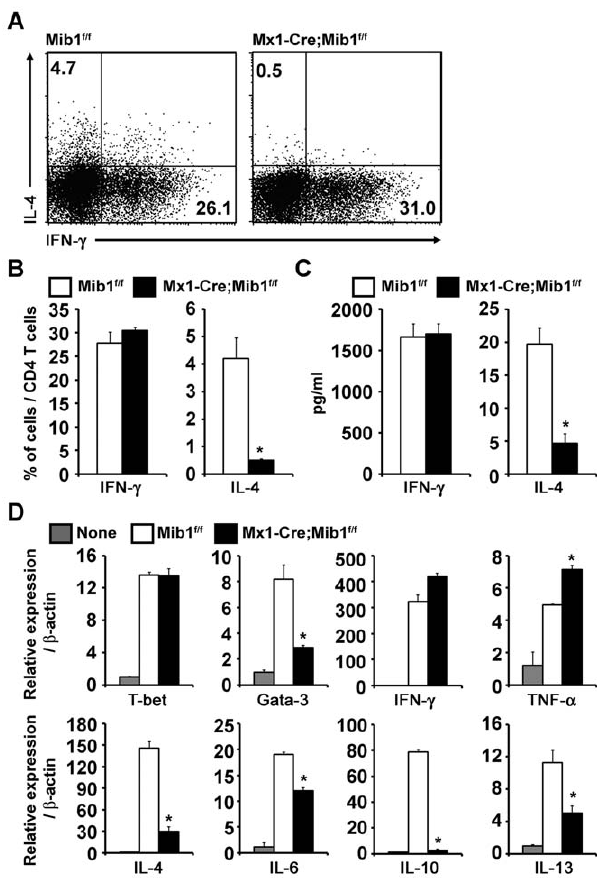
Figure 5. Absence of Mib1 in DCs specifically impairs Th2 differentiation. A , Purified naive OT-II CD4 + T cells were cultured with peptide pretreated Mib1 f/f or Mx1-Cre;Mib1 f/f DCs. After 5 days, viable cells were re-stimulated with PMA and ionomycin for 6 h, and the intracellular levels of IFN- c and IL-4 were analyzed by flow cytometry. The numbers indicate the percentage of cells within the gates. A representative of three independent experiments is shown. B , The average percentage of activated CD4 + T cells producing IFN- c and IL-4 (as in [ A ]) from three independent experiments. C , Viable activated CD4 + T cells were harvested, and an equal number of cells in each group were re-stimulated with 1 m g/ml plate-bound anti-CD3. The supernatants were removed after 48 h, and cytokine concentrations were determined by ELISA. D , Quantitative real-time RT-PCR analysis of T-bet, Gata-3, Th1 related cytokines (IFN- c and TNF- a ), and Th2 related cytokines (IL-4, IL-6, IL-10, and IL-13) in purified CD4 + T cells unstimulated ( None ) or stimulated by Mib1 f/f or Mx1-Cre;Mib1 f/f DCs. Data represent mean 6 SD; *, P , 0.05. doi:10.1371/journal.pone.0036359.g005 ELISA analysis (Fig. 5 C ). In addition, expressions of Gata-3, a central factor for the differentiation of Th2 cells, and various Th2 cytokines such as IL-4, IL-6, IL-10, and IL-13 were notably reduced in the CD4 + T cells cultured with Mib1-null DCs (Fig. 5 D ). In contrast, expressions of T-bet, a master regulator of Th1 differentiation, and Th1 cytokines including IFN- c and TNF- a were comparable between the CD4 + T cells stimulated by the control and Mib1-null DCs (Fig. 5 D ).